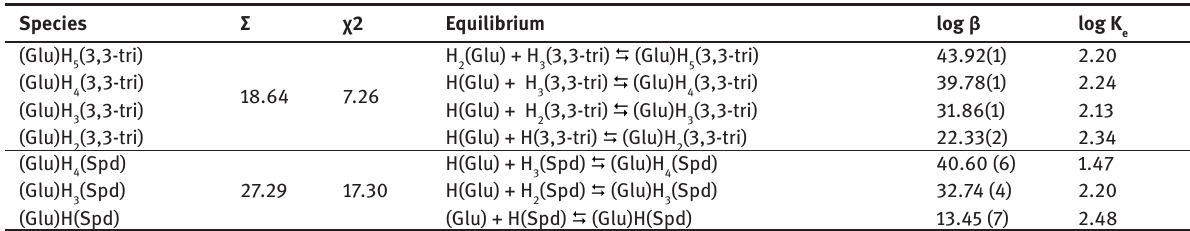
*Overall protonation constants of the ligands: H